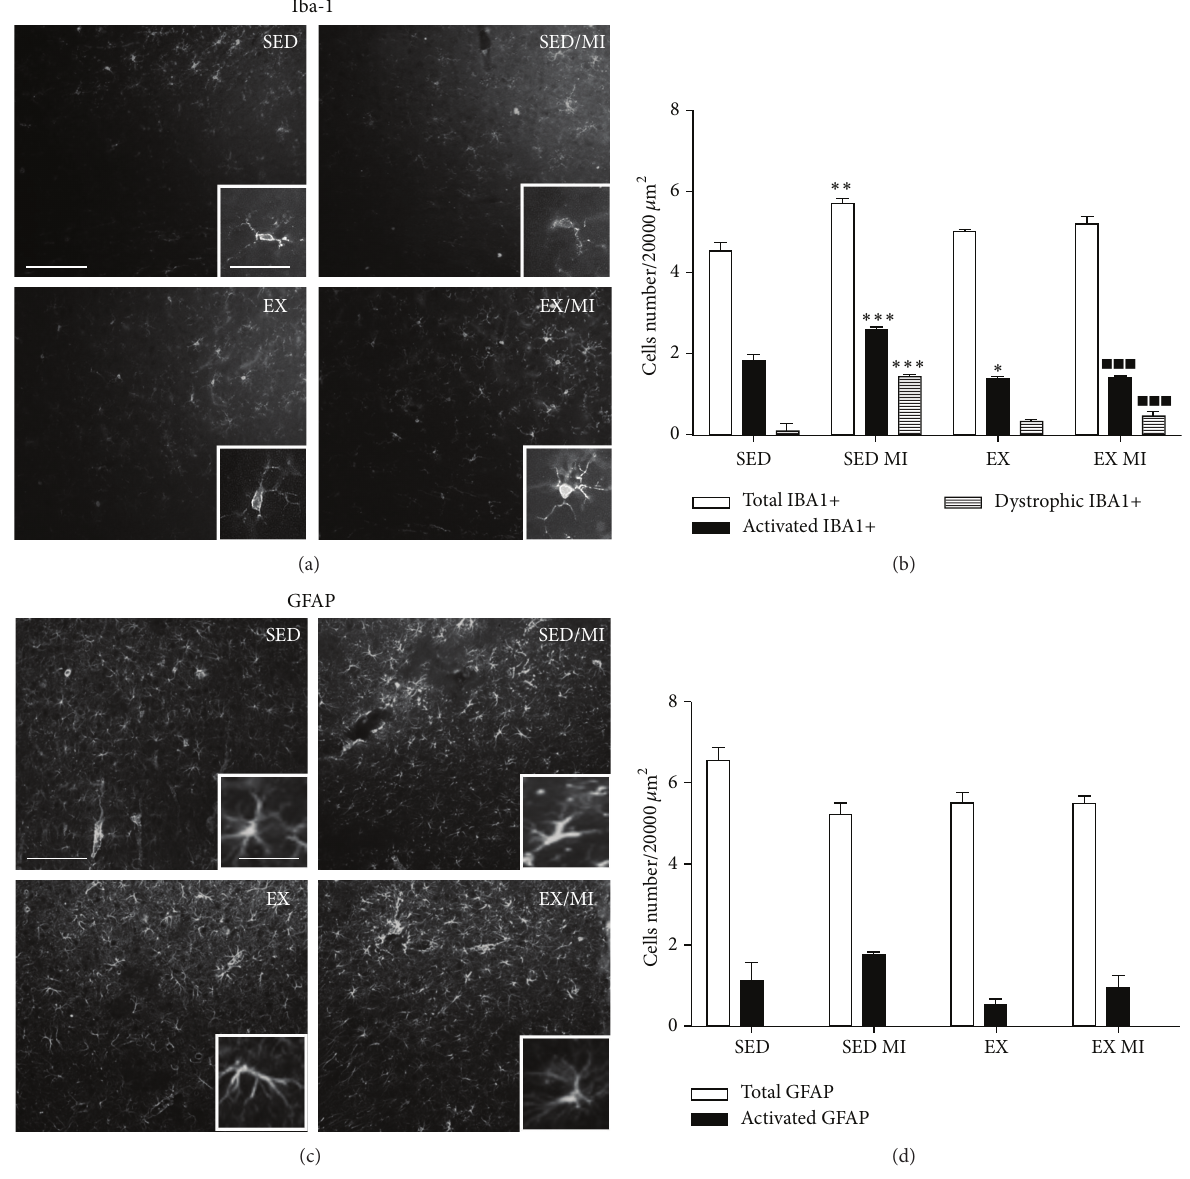
Figure 3: Effect of prolonged exercise on MI induced microglia and astrocyte morphological changes in the hippocampus. 48h MI induced significant changes in hypertrophic 2.6 ± 0.05 and senescent 1.4 ± 0.03 (dystrophic-like) microglia in the hippocampus as compared to the sedentary group without MI ( 1.80 ± 0.19 and 0.11 ± 0.19 ). Both phenotypes were significantly reduced by the prolonged exercise ( 1.4 ± 0.04 and 0.47 ± 0.1 ) (a, b). 48h MI did not modify the total or reactive astrocyte number in the hippocampus ( 5.2 ± 0.26 and 1.74 ± 0.07 ) (c, d). Data are presented as mean ± SEM. ANOVA followed by Tukey post hoc test was used for statistical analysis. Three animals were used for each experimental group. ∗ 𝑃 < 0.05, ∗∗ 𝑃 < 0.01 , and ∗∗∗ 𝑃 < 0.001 versus sedentary group; z 𝑃 < 0.05 , zz 𝑃 < 0.01 , and zzz 𝑃 < 0.001 versus sedentary group with MI. Scale bars 100 and 25 𝜇 m for panoramic and inset image, respectively. Scale bars 100 and 25 𝜇 m for panoramic and inset image,